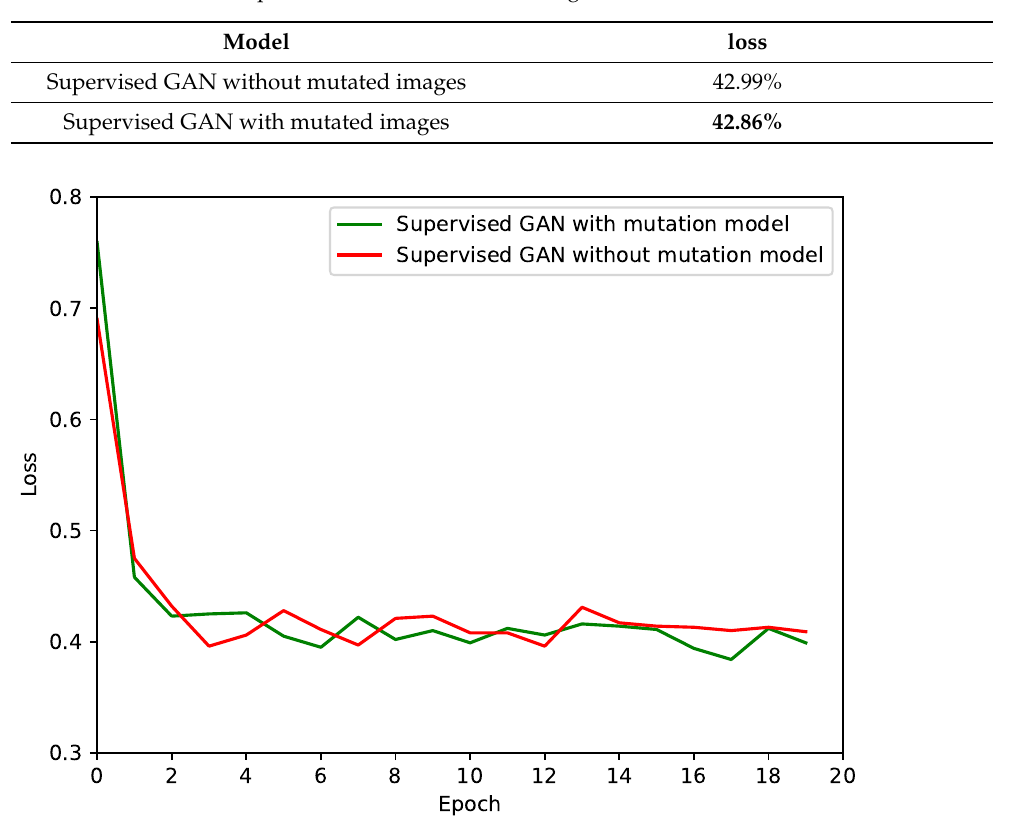
Table 4. The training set of the ISLES-2018 dataset is used to present the average loss value of training the SNN module for 20 epochs with and without an integrated mutation model.